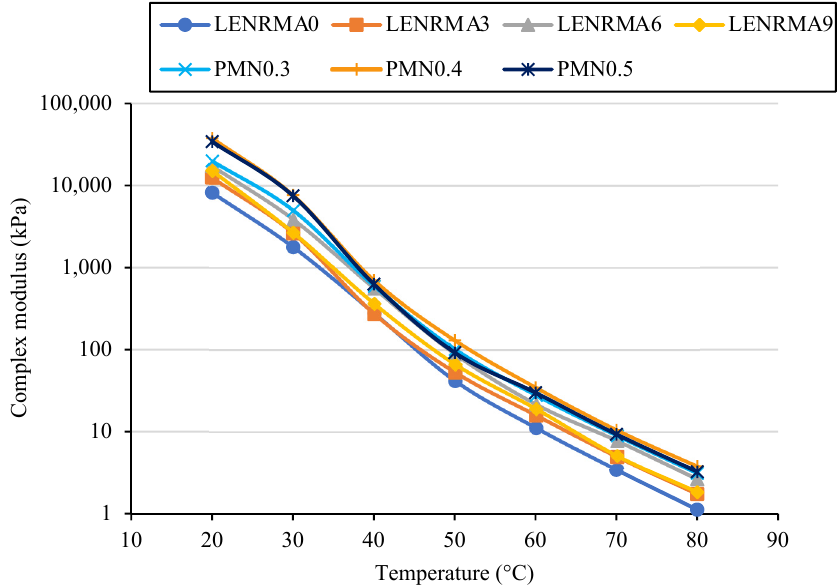
Figure 11. Complex modulus versus temperature at 10 Hz of binders (isochronal plots).